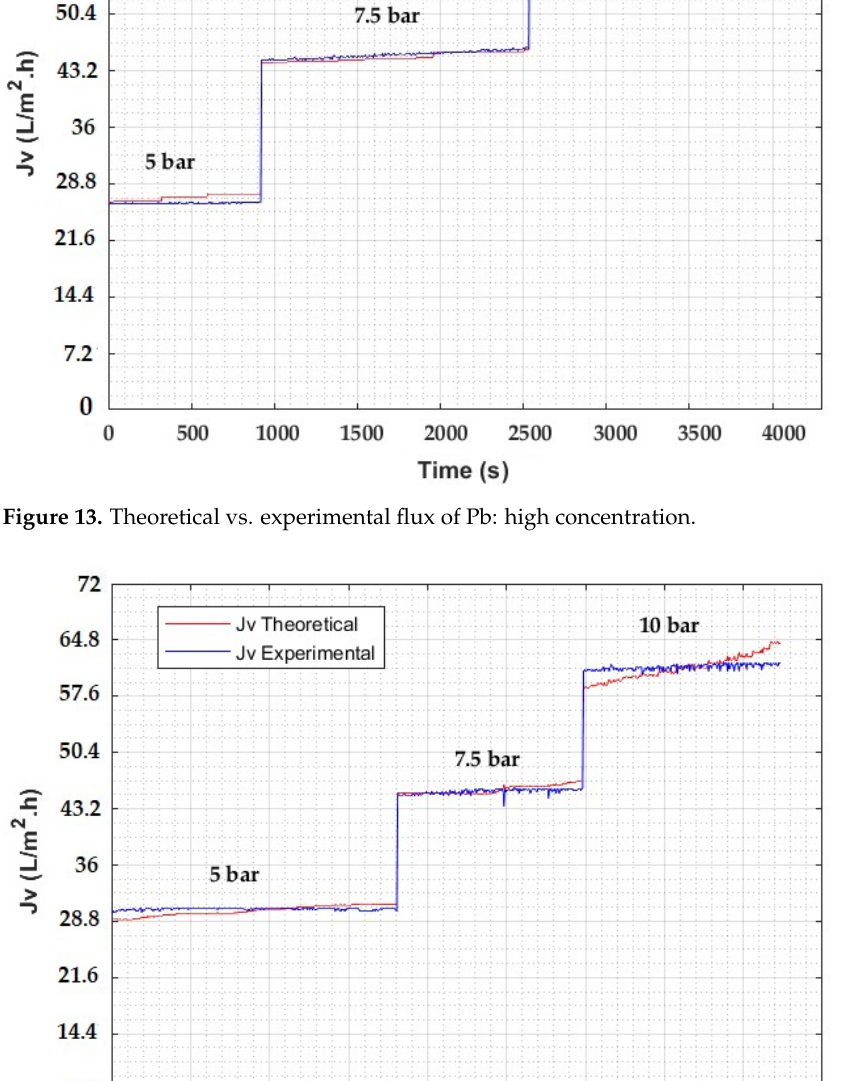
Figure 14. Theoretical vs. experimental flux of As: low concentration.